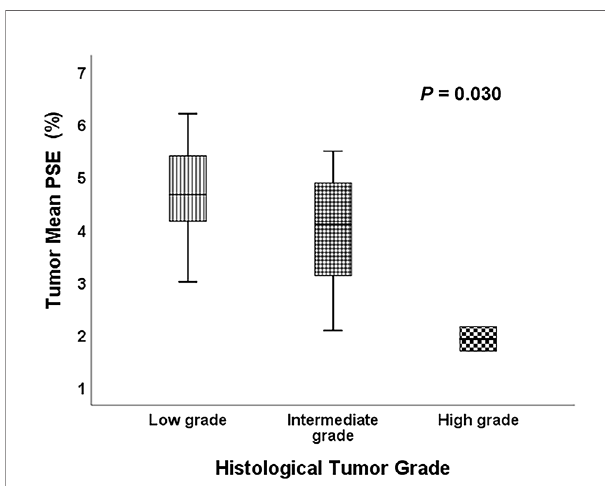
FIGURE 3 | Comparison of the tumor mean PSE between different histological tumor grades using the Kruskal-Wallis test.